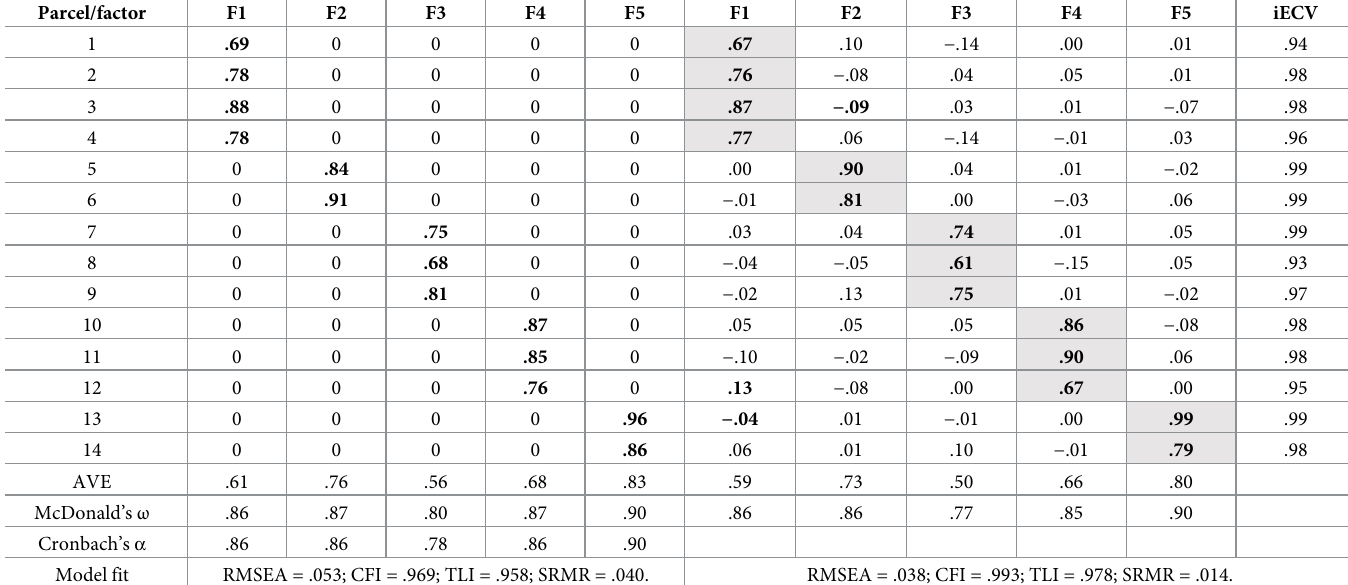
Table 2. Results of the CFA and ESEM